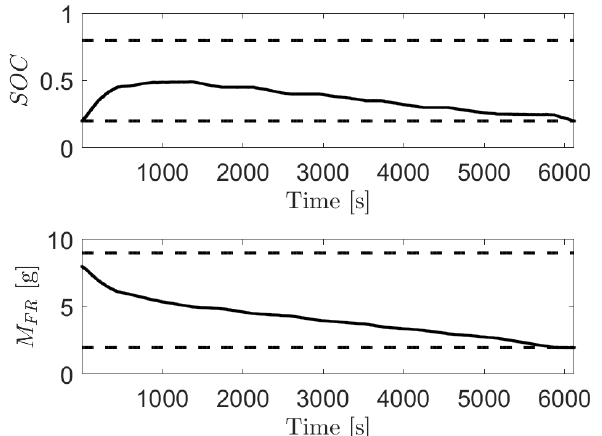
Figure 12. SOC and remaining M FR versus time, Simulation Scenario II; dashed lines show constraints.